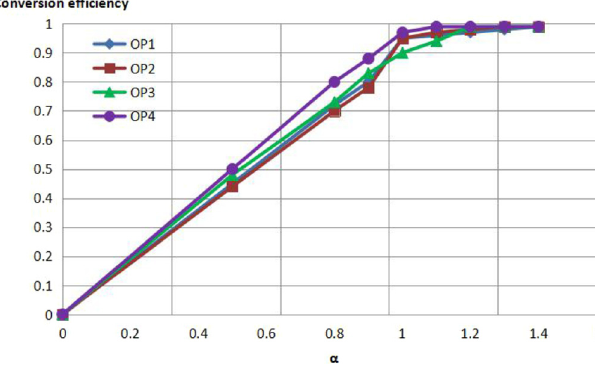
Fig. 16. Conversion ef fi ciency of NO X